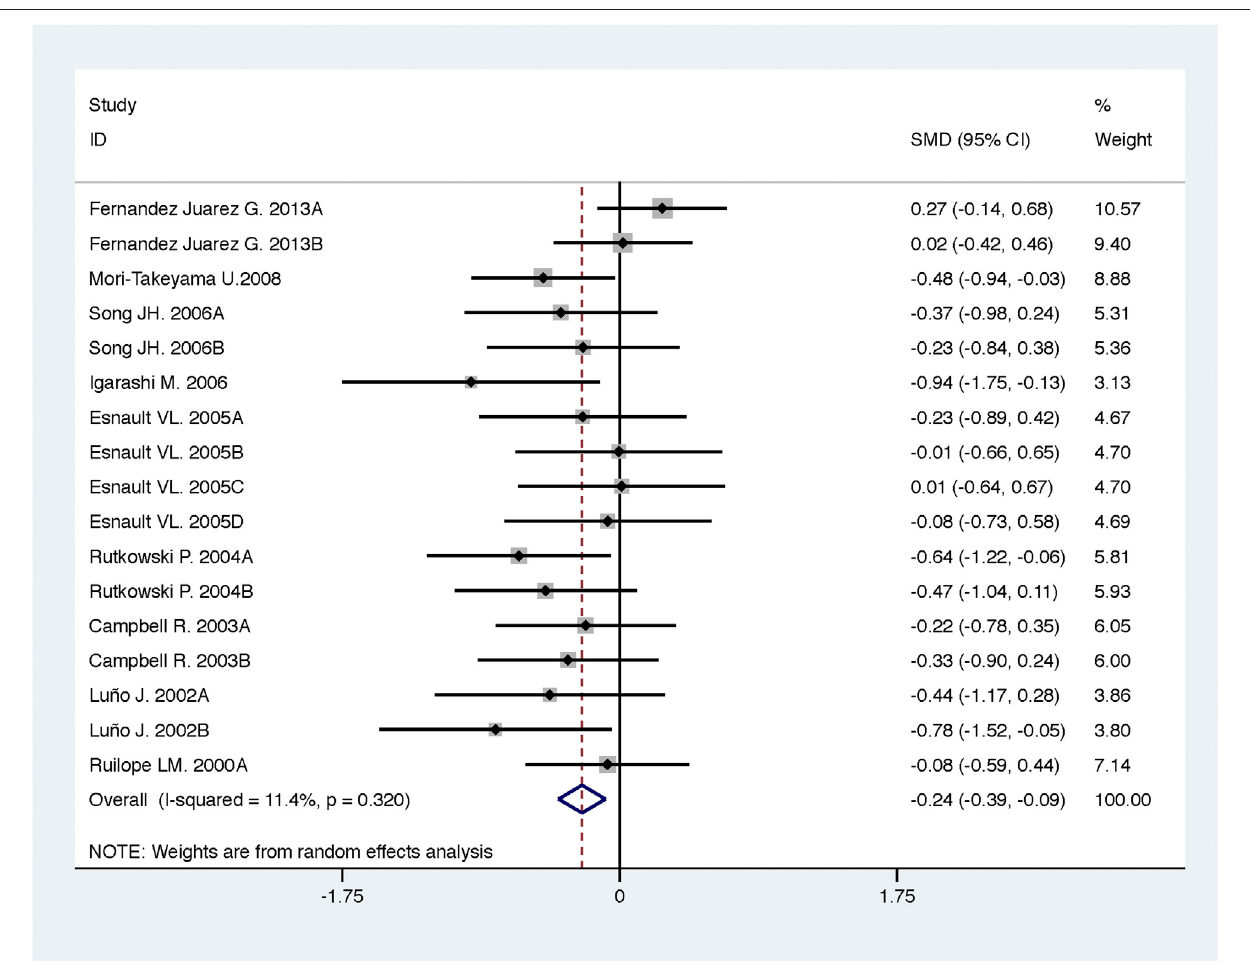
FIGURE 9 | Comparison of ACEI in combination with ARB vs. high-dose ACEI or ARB for urine protein excretion (g/g of creatinine or g/24 h).